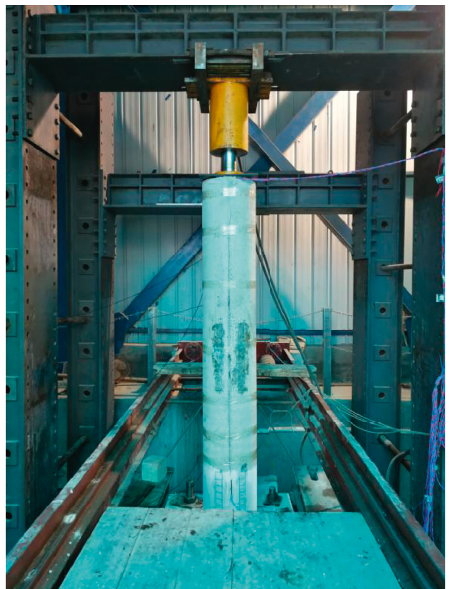
Figure 7: Axial pressure device.